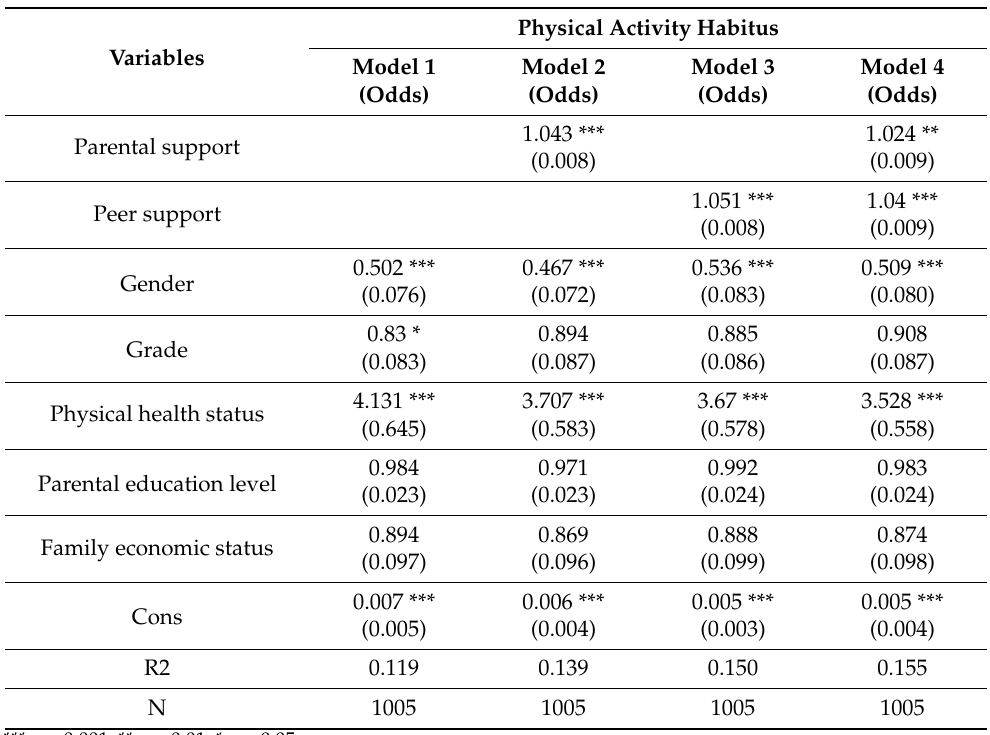
Table 6. Logistic regression models of parental support and peer support on college students’ physical